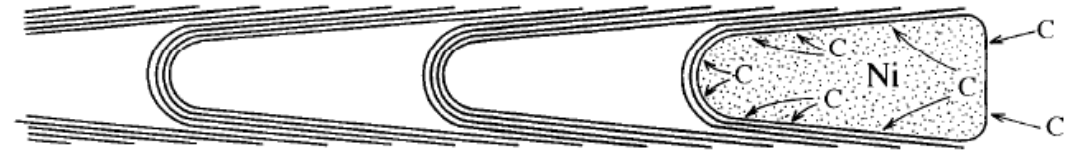
Figure 15. Pushing growth mechanism of BCNTs formation [59].